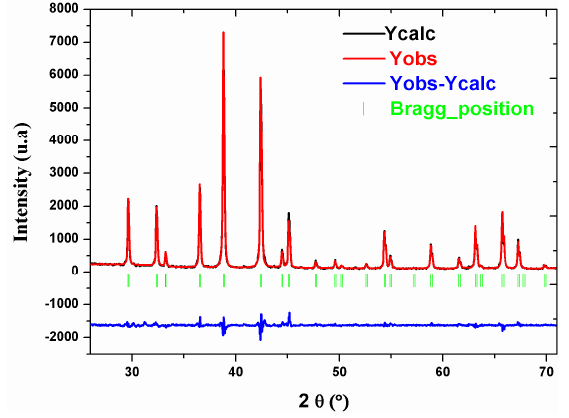
Figure 1. Rietveld refinement of Er 6 Fe 20 Al 3 compound. Table 1. Details of structure refinement for Er 6 Fe 20 Al 3 .